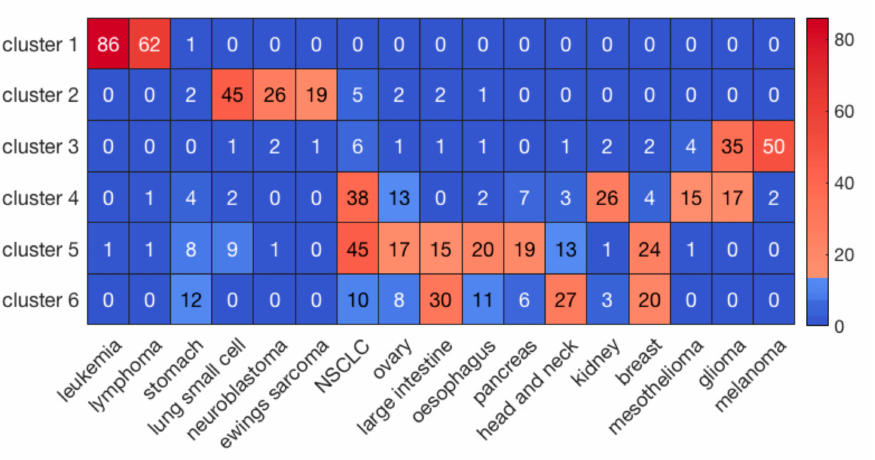
Figure 1. The clustering results of cell lines for the major 17 cancer types. The sidebar indicates the number of cell lines in each